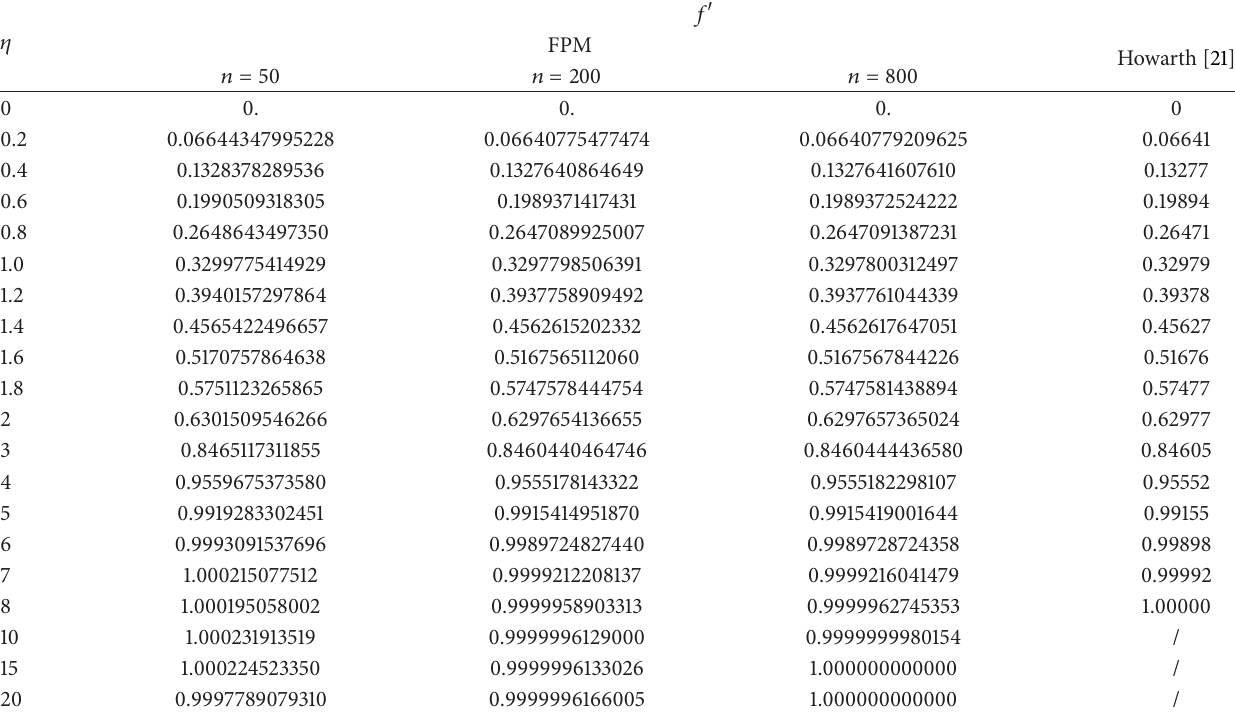
Table 3: Comparison of 𝑓 󸀠 between FPM ( 𝜆 = 1/5 ) and